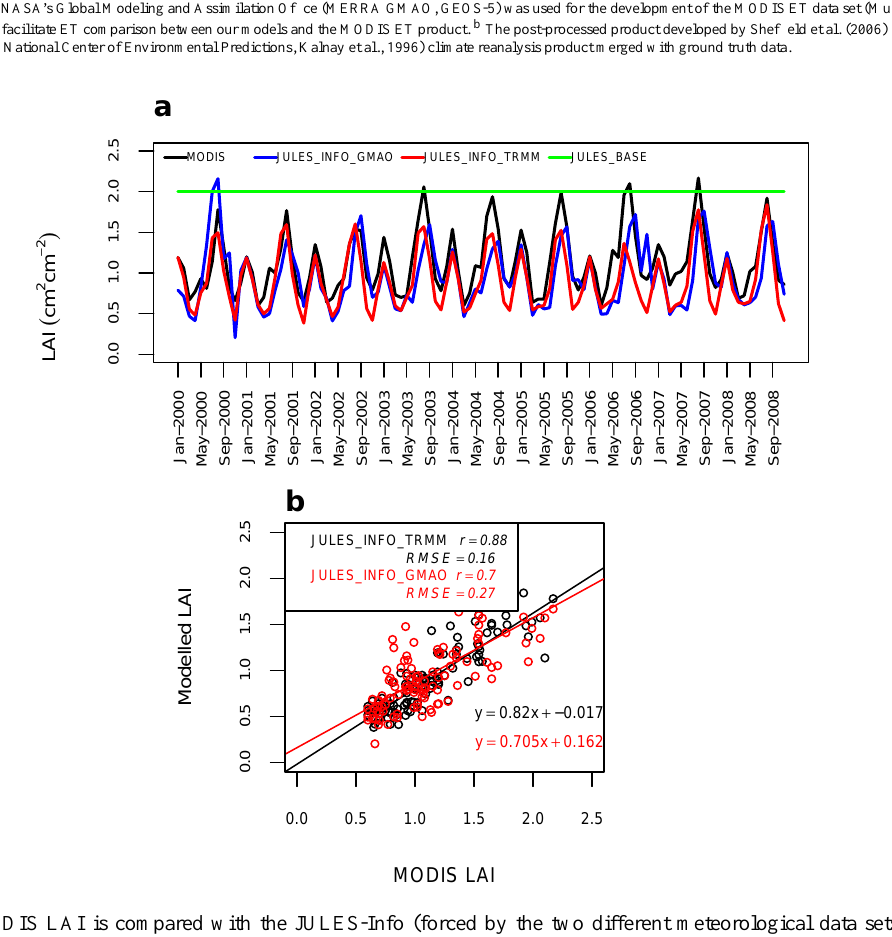
Figure 4. (a) The MODIS LAI is compared with the JULES-Info (forced by the two different meteorological data sets) modelled LAI. JULES-base was run with its default LAI value set to 2 for crops. (b) Performance scores JULES-Info with TRMM and GMAO forcing data sets. The results show that the modelled LAI matches the observed MODIS LAI well. The two peaks per year represent the two cropping seasons as specified by the crop